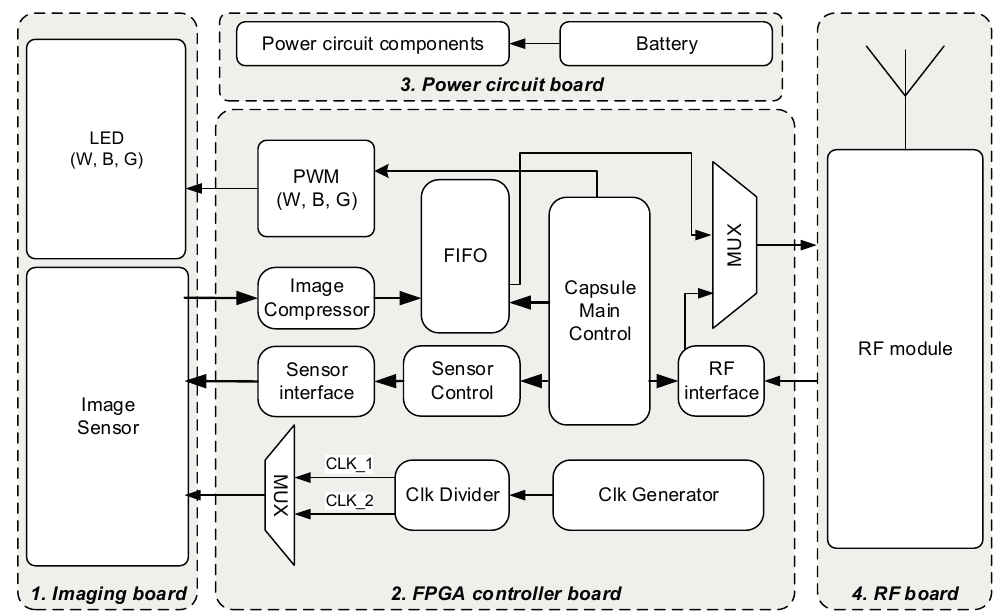
Figure 8. Architecture of the capsule